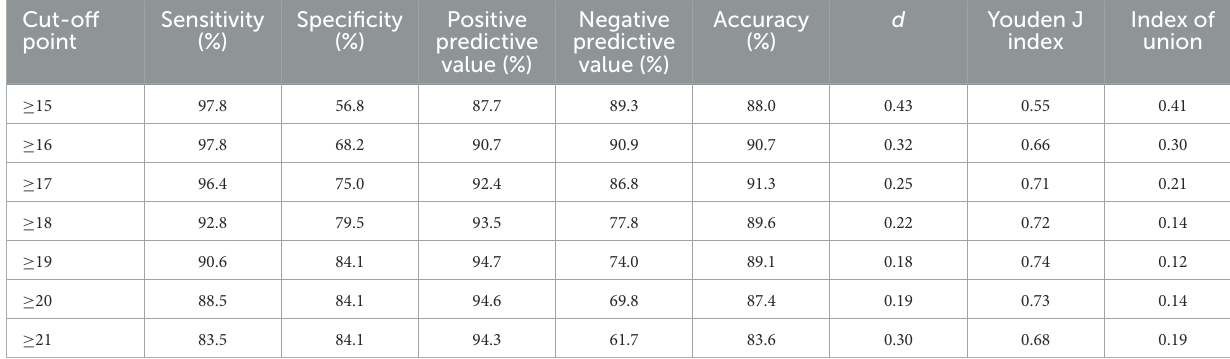
TABLE 4 Predictive properties of the Vietnamese version of the Hamilton D-17 scale at different cutoffs. Cut-off